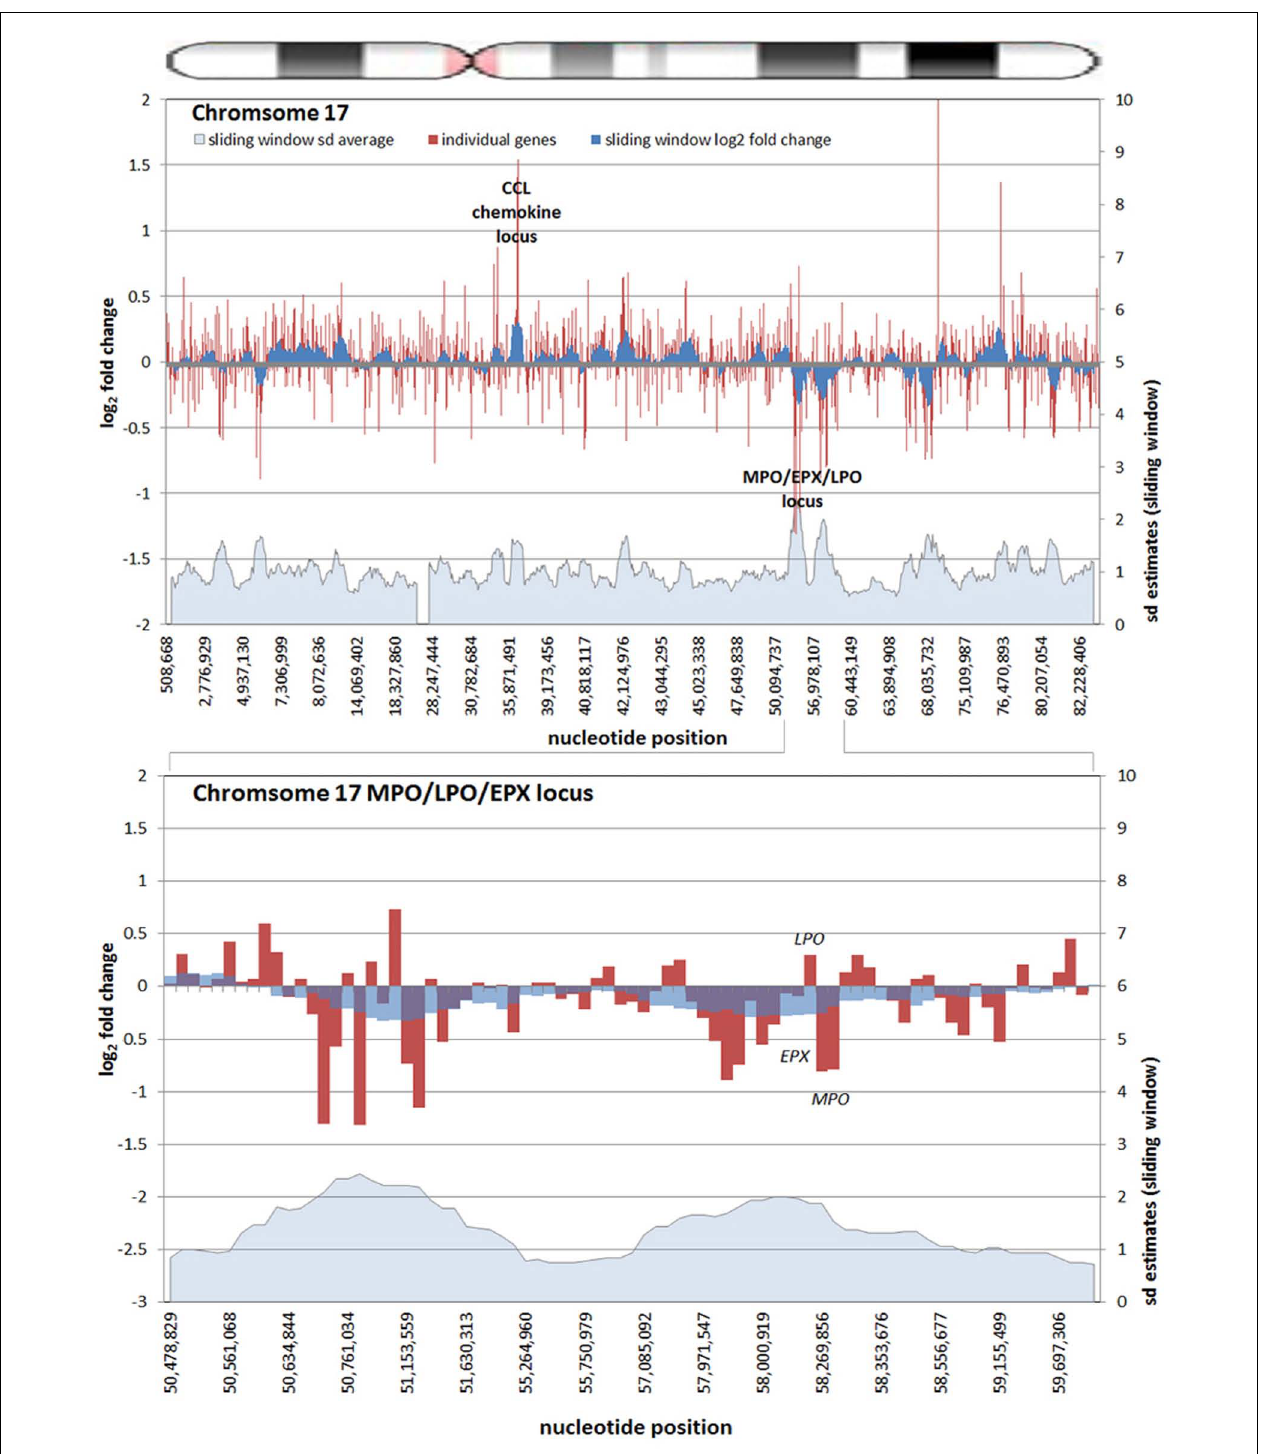
FIGURE 3 | Differential gene expression patterns cluster over large linear genomic regions in A. phagocytophilum -infected human peripheral blood neutrophils. The top panel shows human chromosome 17; the bottom panel shows the MPO / EPX / LPO locus on human chromosome 17 and the large genomic region that is upregulated with infection. The chromosome ideogram is shown at the top. Red bars (left axes) represent differential transcription of individual genes, including some